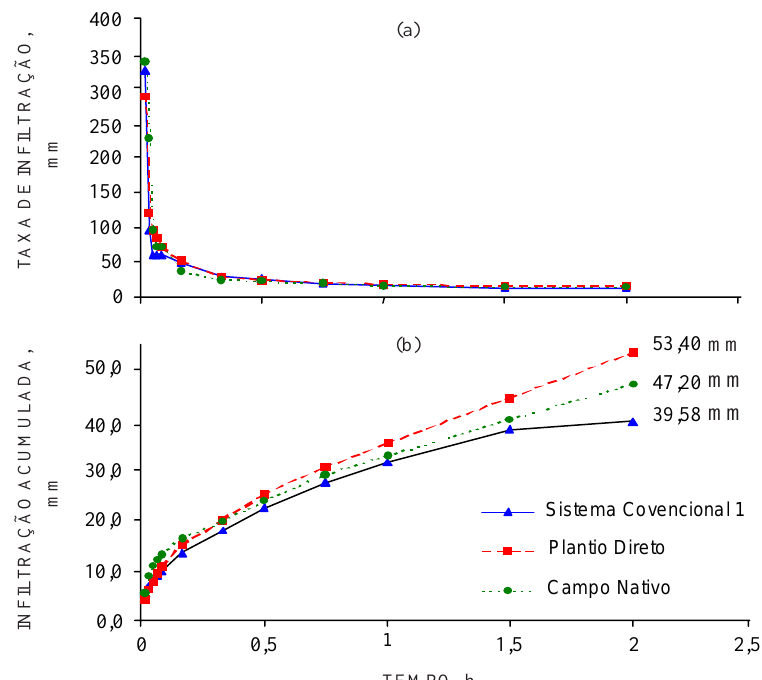
Figura 1. Taxa de infiltração (mm h -1 ) – (a) e infiltração acumulada (mm) – (b), de um Argissolo Vermelho submetido a diferentes sistemas de manejo de acordo com o tempo